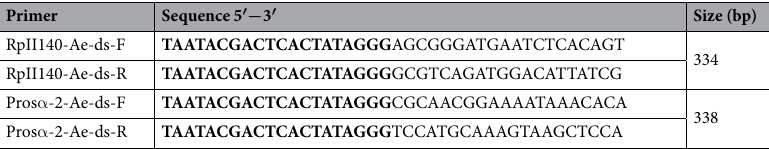
Table 4. Primers used for dsRNA synthesis. Bold letters represent the T7 promoter